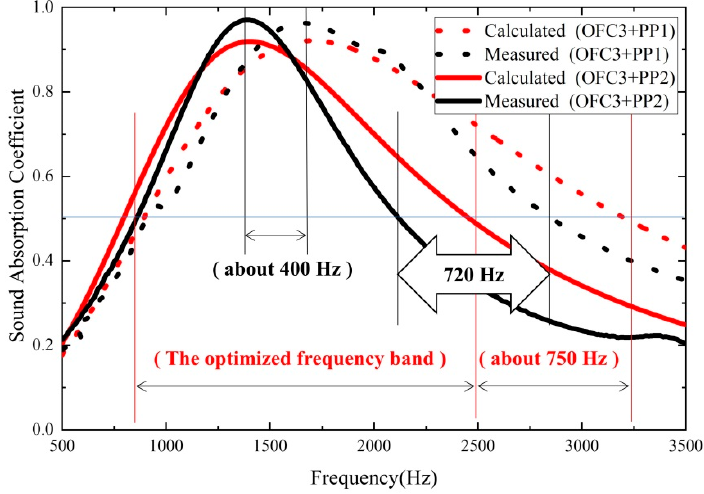
Figure 9. The sound absorption coefficient curve of the optimized composite structure.